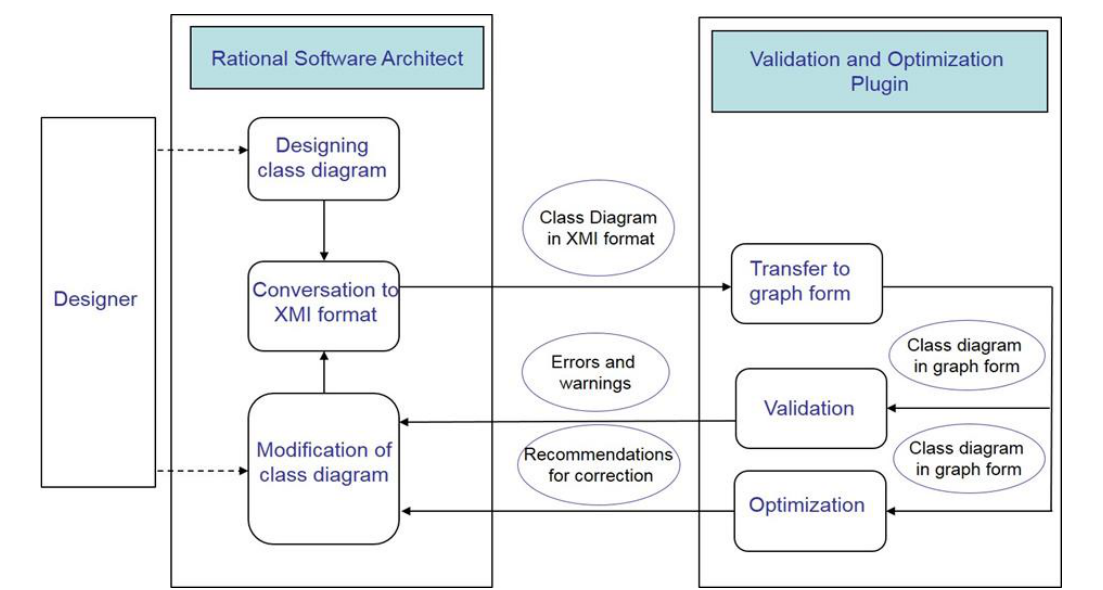
Fig. 5. Structural scheme, describing the operation of the improved CASE